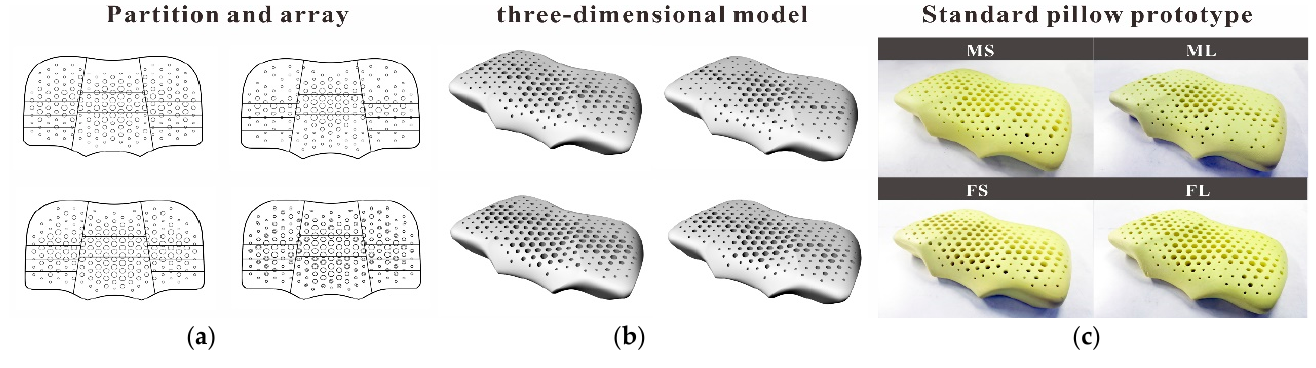
Figure 9. Pore diameter-equivalent elastic coefficient regression curve.